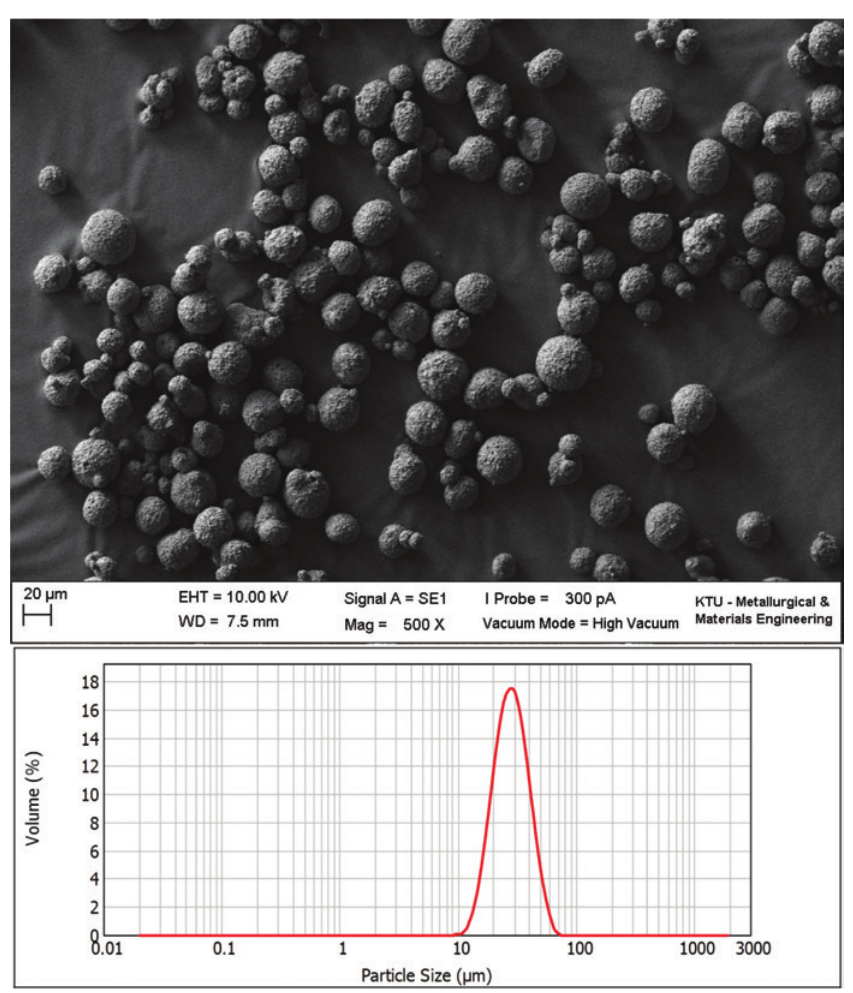
Fig. 1: Powder morphology of WC-12Co and distribution of particle